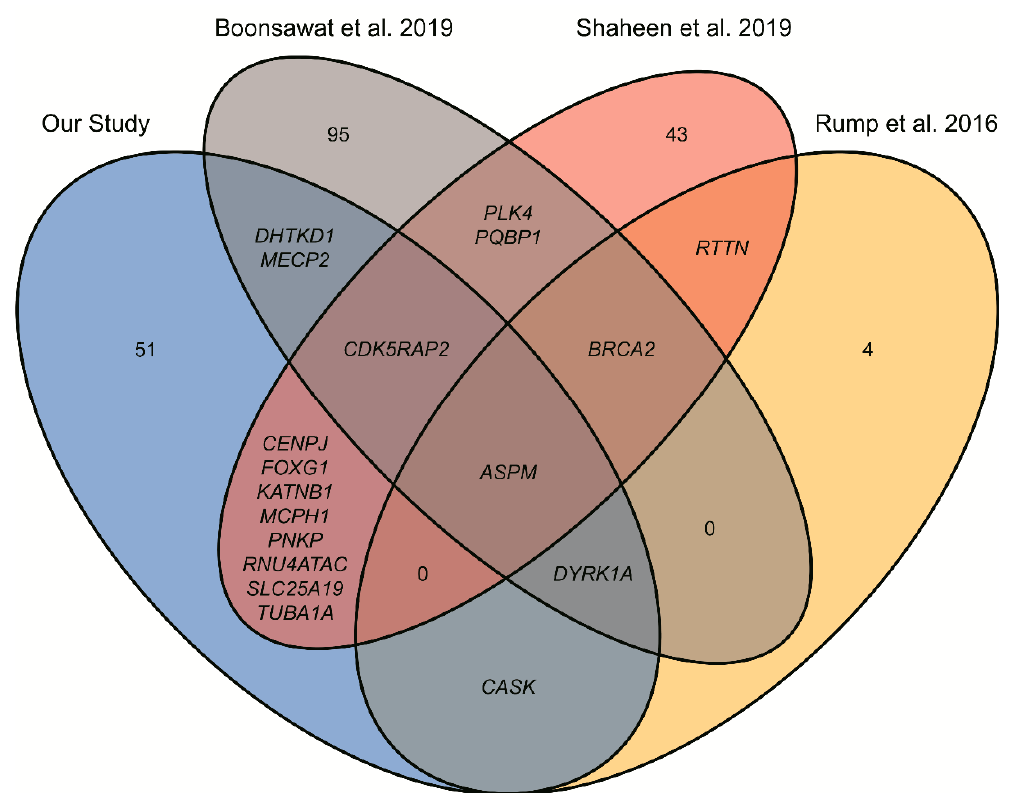
Figure 2. Venn diagram showing number and symbols of unique and shared genes identified in four studies on different microcephaly patients.